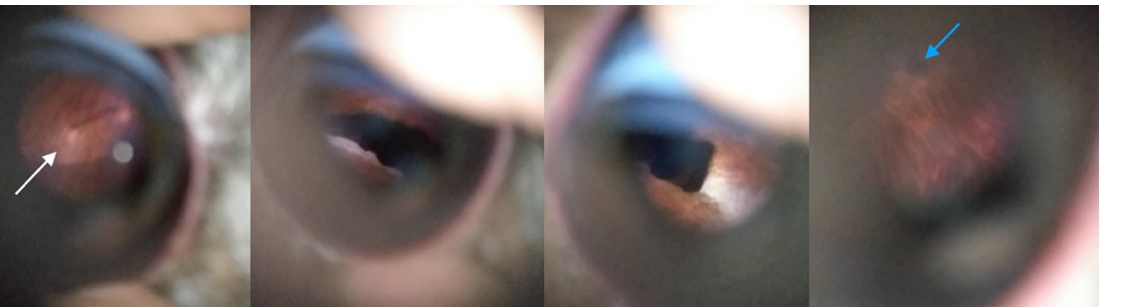
Figure 5. Fundus of a hobby falcon ( Falco subbuteo ) showing an anomaly of the pecten (white arrow). A degenerative process secondary to eye trauma was suspected. This fundus examination was clas- sified as acceptable as fundus components were identified, but the examination was not totally sat- isfactory because of blur and light reflection. In the cumulative odds ordinal logistic regression with proportional odds to deter- mine the effect of eye shape, pupillary dilation quality, and iris color on the quality of the fundus assessment using the Peek Retina ® device, the assumption of proportional odds was met, as assessed by a full likelihood ratio test comparing the fit of the proportional odds model to a model with varying location parameters ( χ 2 (4) = 3.8, p = 0.43). The final model statistically significantly predicted the dependent variable over and above the in- tercept-only model ( χ 2 (4) = 53.4, p < 0.001). Eye shape, iris color, and pupillary dilation statistically significantly predicted the quality of the Peek Retina ® fundus assessment (Wald- χ 2 (2) = 8.3, p = 0.016; Wald- χ 2 (1) = 14.2, p < 0.001; and Wald- χ 2 (1) = 5.1, p = 0.024, respectively). More specifically, the odds of the presence of bright iris allowing the as- sessment of bird’s fundus with the Peek Retina ® device was 0.06 (95% CI, 0.01 to 0.26) times that for the presence of a dull iris. Therefore, the presence of a bright iris significantly diminished the quality of the fundus assessment using the Peek Retina ® device. The “bright’ category included the yellow iris color of heron and sparrowhawk and orange iris color of adult pigeons and chickens. It is of note that the fundus assessment with the Peek Retina ® device was possible with variable quality in all eyes with a yellow iris, but in none of the eyes with an orange iris. The odds of globular eyes allowing the assessment of bird’s fundus with Peek Retina ® was 0.06 (95% CI, 0.01 to 0.56) times that of tubular eyes—a statistically significant effect ( χ 2 (1) = 6.1, p = 0.014). The odds of flat eyes allowing the assessment of bird’s fundus with Peek Retina ® was 0.04 (95% CI, 0.01 to 0.35) times that of tubular eyes—a statistically significant effect ( χ 2 (1) = 8.3, p = 0.004). Therefore, the presence of a globular eye and a tubular eye significantly diminished and increased the quality of the fundus assessment using the Peek Retina ® device, respectively. The odds of the quality of pupillary dilation allowing the assessment of bird’s fundus with the Peek Retina ® device was 2.4 (95% CI, 1.1 to 5.1). Therefore, the quality of pupillary dilation significantly increased the quality of the fundus assessment using the Peek Retina ® device.